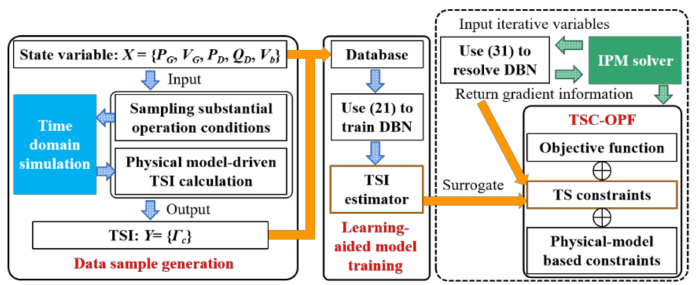
Figure 1. The flow chart of the proposed